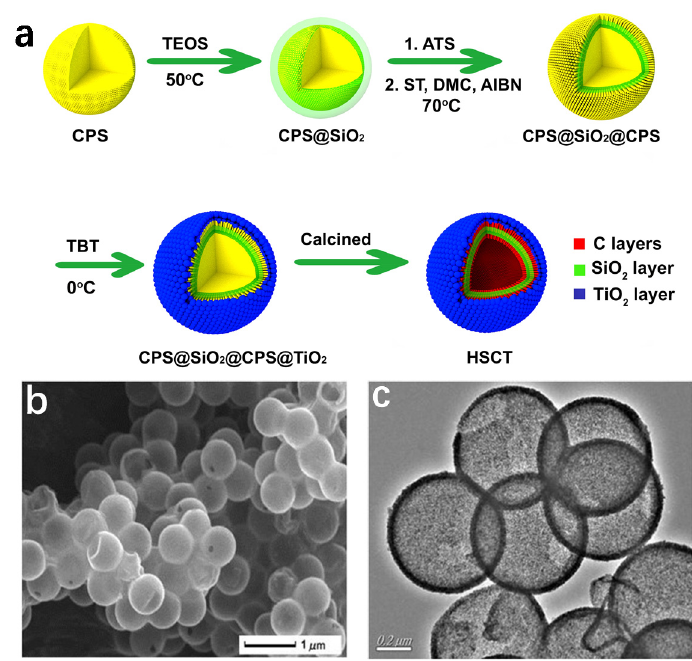
Figure 4. Preparation ( a ), SEM ( b ), and TEM ( c ) of the hierarchical SiO 2 @C-doped TiO 2 spheres. Reprinted with permission from Ref. [9]. Reprinted with permission from Ref.